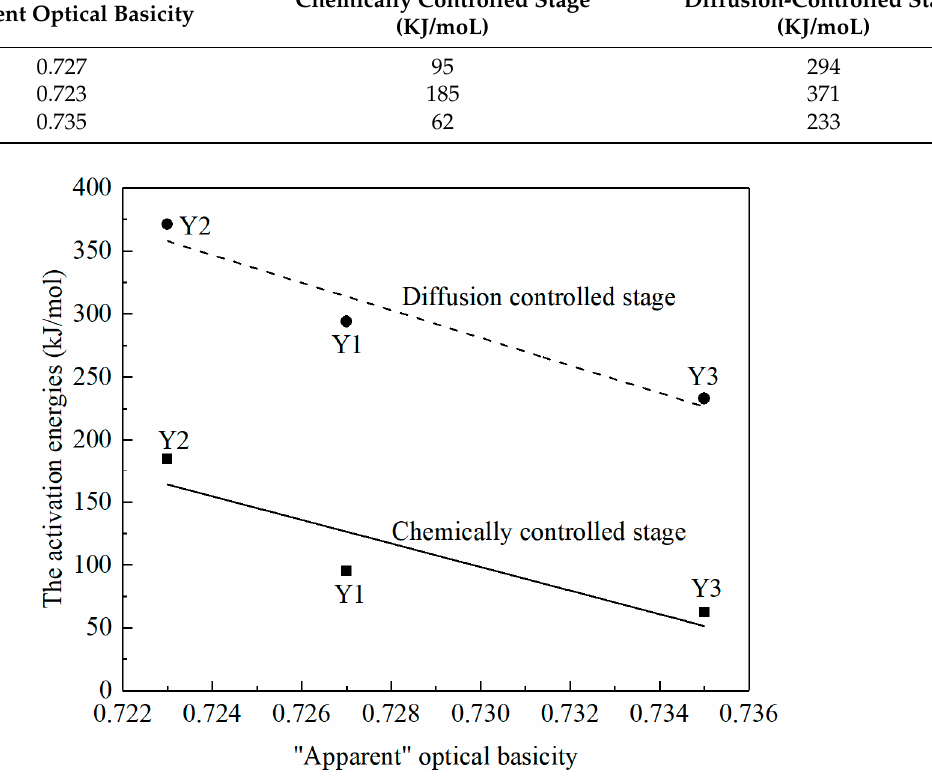
Figure 11. The relationships between the activation energies and slag apparent optical basicity at the chemically and diffusion-controlled stages.